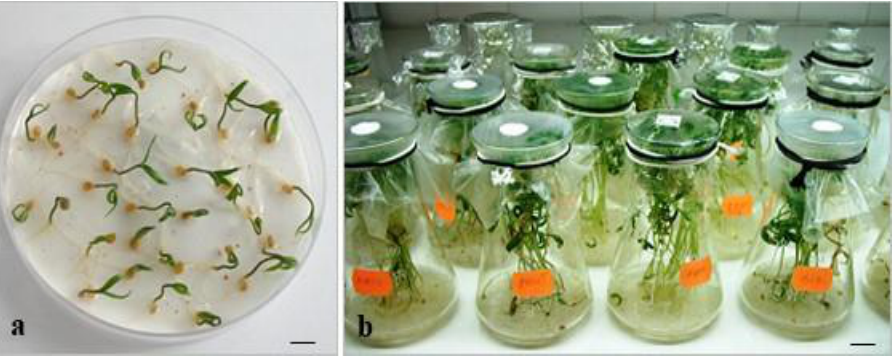
Figure 2. Tomato seed germination. ( a ) ex vitro seed germination (cv. ‘Kristin’); ( b ) in vitro seed germination (cv. ‘Kristin’). Size bars = 1.0 cm.